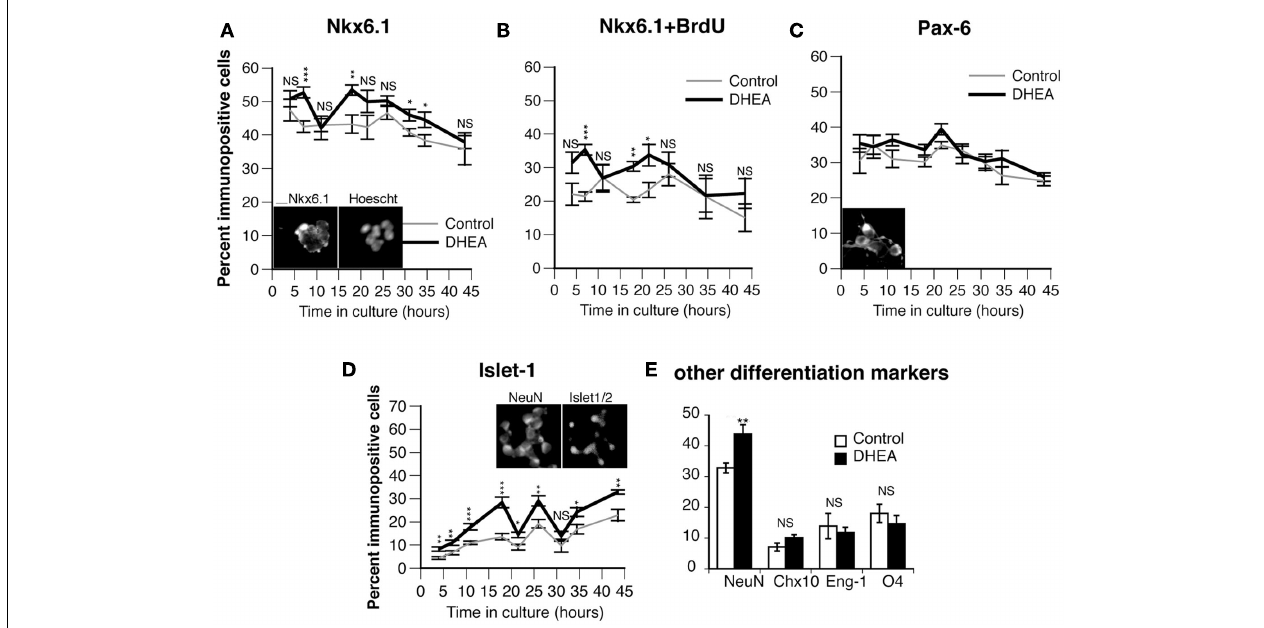
FIGURE 4 | Effect of DHEA on the proliferation of committed precursors in cultures and on the generation of motor neurons in vitro. Cells isolated from E10.5 mouse neural tube lumbar region were cultured in the presence (black line) or in the absence (control, gray line) of DHEA for different periods of time and stained for BrdU and Nkx6.1. (A) Percent of Nkx6.1 + cells. (B) Percent of dividing Nkx6.1 + cells (dually labeled Nkx6.1 and incorporating